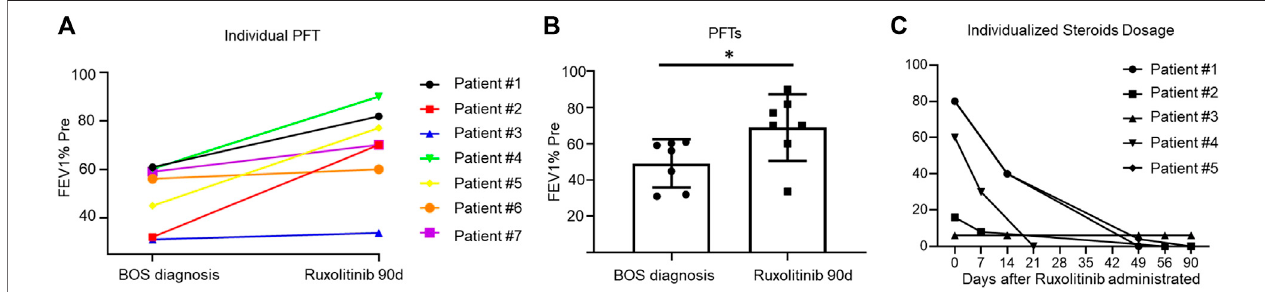
FIGURE 1 | (A) : Line graph showing the individualized fl uctuation of FEV1% at BOS diagnosis and 3 months after ruxolitinib administration. Figure 1B : FEV1% pred between patients at BOS diagnosis and 3 months after ruxolitinib administration. Figure 1C : A line graph showing the individualized steroids dosing over time during the study